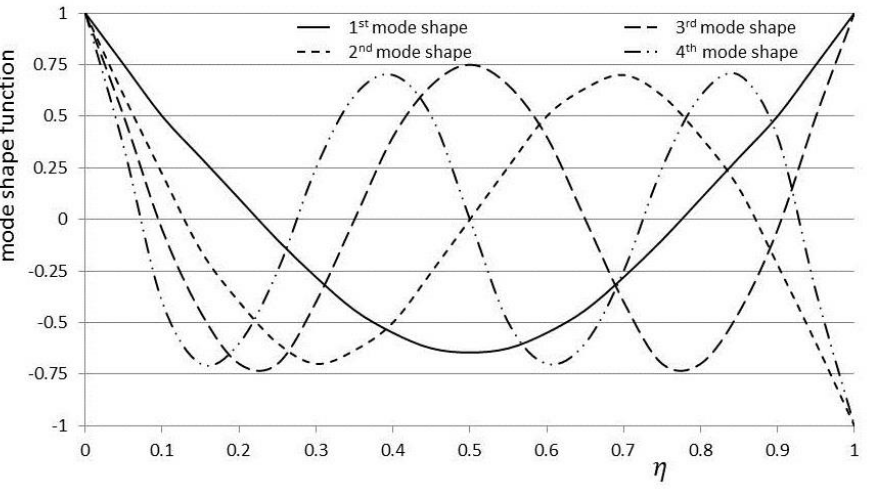
Figure 4. The first four mode shape functions for β = 0.5 .